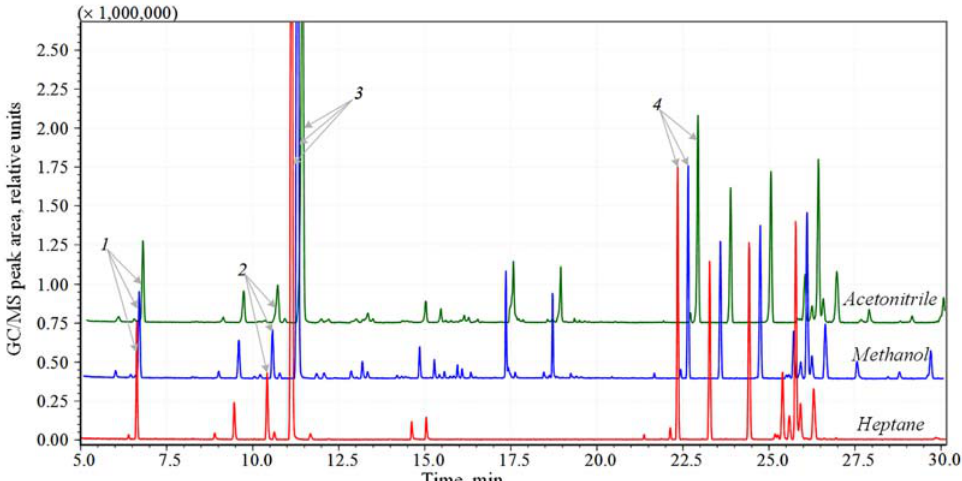
Figure 2 . The chromatographic profile of B. tripartita L. volatile compounds obtained by supercritical fluid extraction using different trap rinse sol- vents (1 – α -pinene; 2 – p -cymene; 3 – β -ocimene; 4 – β